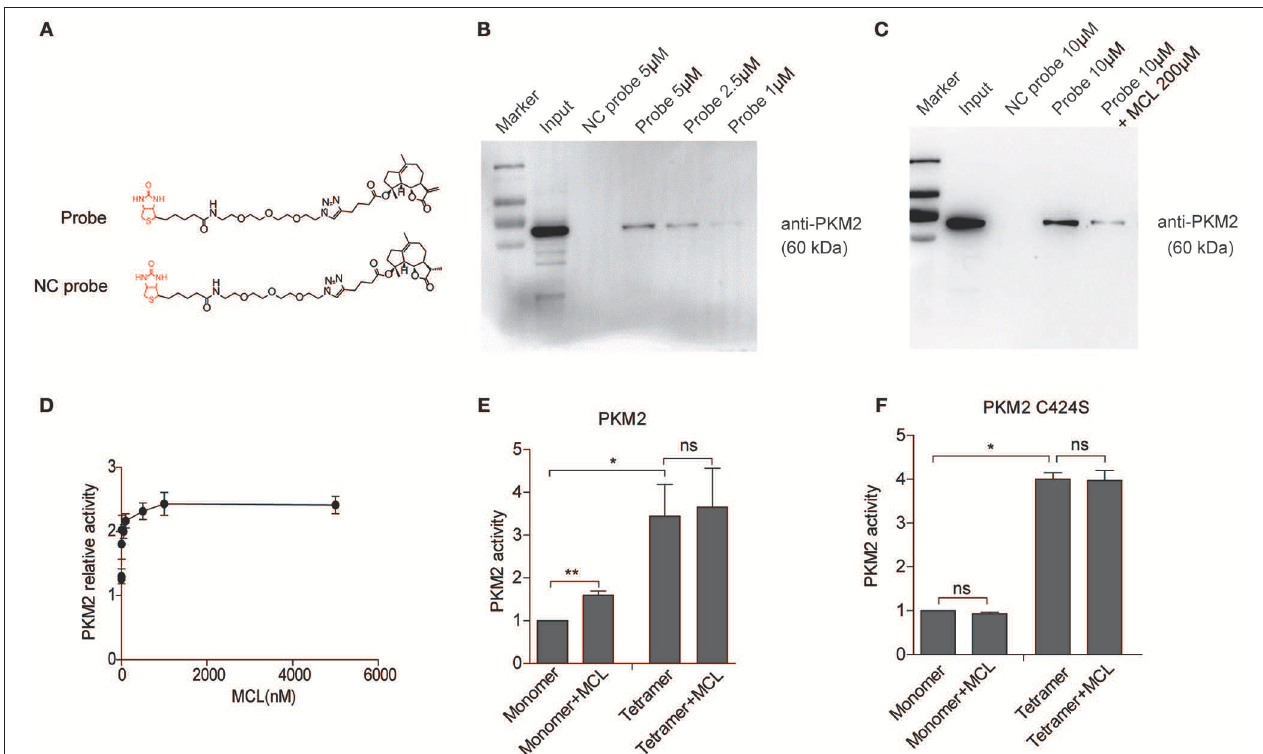
FIGURE 2 | MCL promotes the activity of PKM2 mainly by binds on C424 residue of monomer PKM2. (A) Chemical structures of biotin-conjugated MCL (MCL-biotin, Probe) and biotin-conjugated single-bond MCL (MCL-S-biotin, NC probe). (B) Western blot detection of PKM2 proteins from probe-cell lysis mixture. (C) The U118MG cell lysates were incubated with Probe in the absence or presence of a 20-fold excess of unlabeled MCL overnight at 4 ◦ C. PKM2 proteins were detected by western blot. (D) Treatment with MCL at a series of concentrations for 90min, the PKM2 activity was detected. (E) The PKM2 activity of the monomer and tetramer was detected treated with 10 µ M MCL, respectively. (F) PKM2 C424S were purified and the monomer and tetramer were isolated. The activity of PKM2 was determined using the same procedure as above. Error bars, mean ± s.e.m., n = 3 biological replicates. * P < 0.05, ** P < 0.01, ns, no